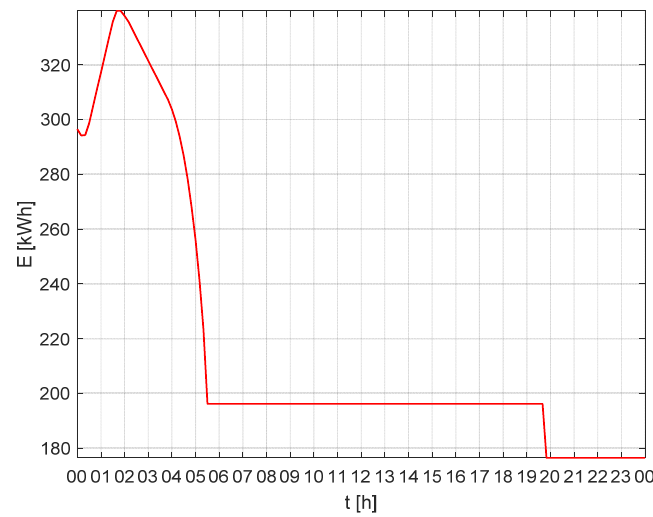
Figure 18. Results of the simulation of the operation of the private network with the BESS with real characteristics for the set PM 400 kW exchange power in the absence of generation; change of energy accumulated in the BESS over time.